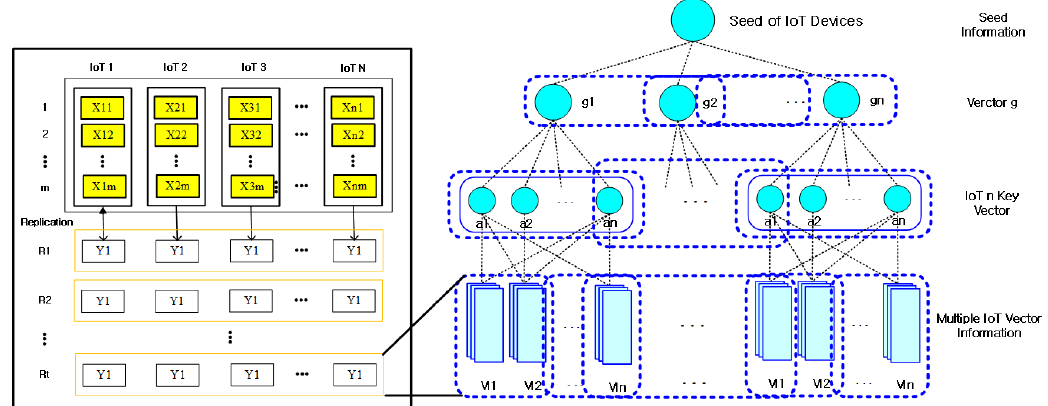
Figure 2. IoT (Internet of Things) information extraction using blockchain.